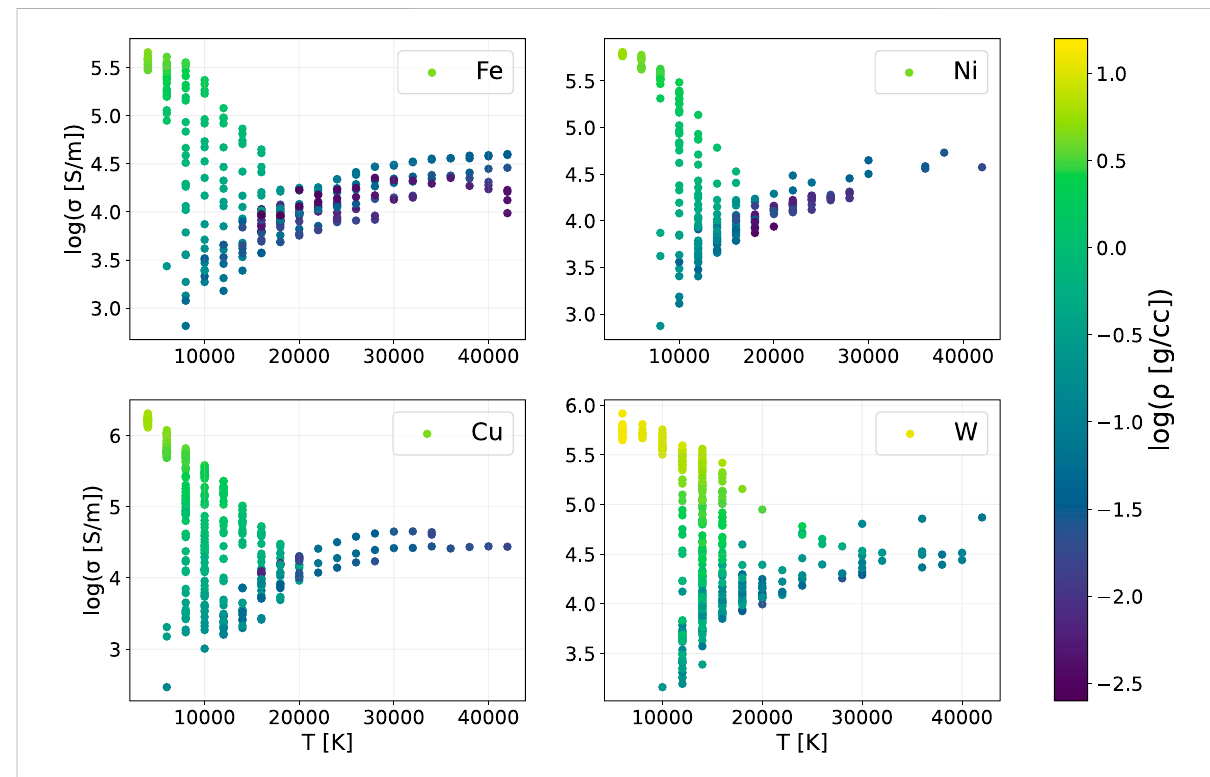
FIGURE 3 DK electrical conductivity data for Fe, Ni, Cu and W. Conductivity is shown versus temperature, with data points color-coded by the mass density. (Conductivity and mass density are shown on logarithmic scales.) Note that the data at high temperatures tend to be at lower densities because of the experimental procedure that employs an exploding